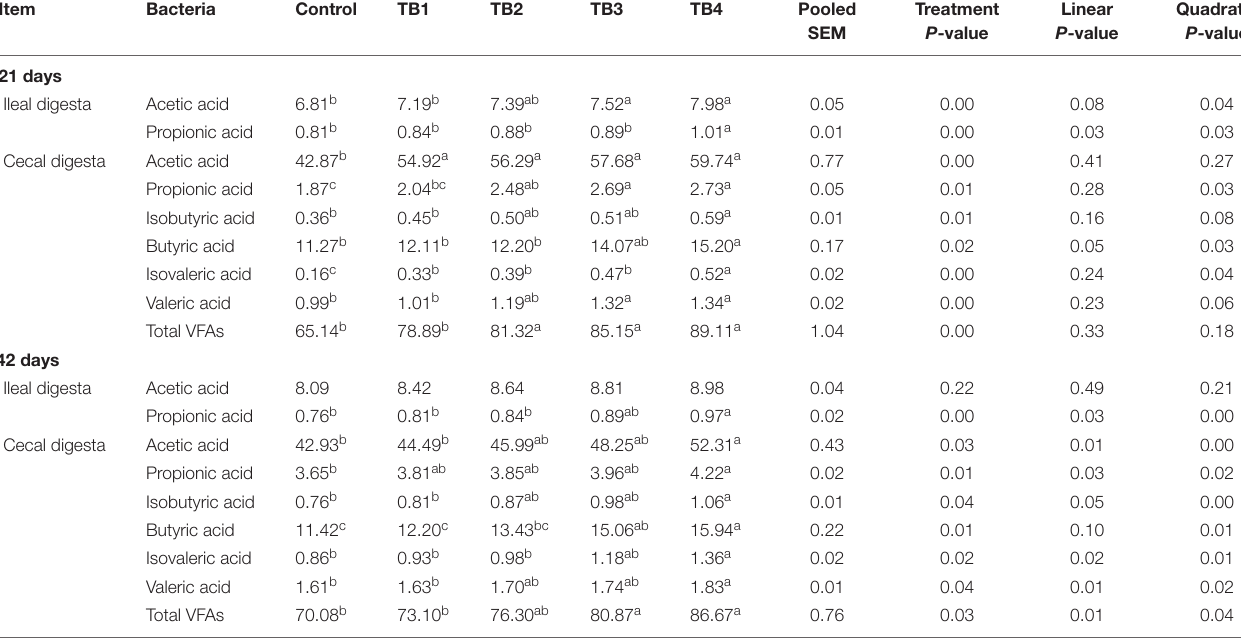
TABLE 5 | Effect of dietary TB on SCFA concentration ( µ mol/g fresh digesta) in ileal and cecal digesta in broilers.